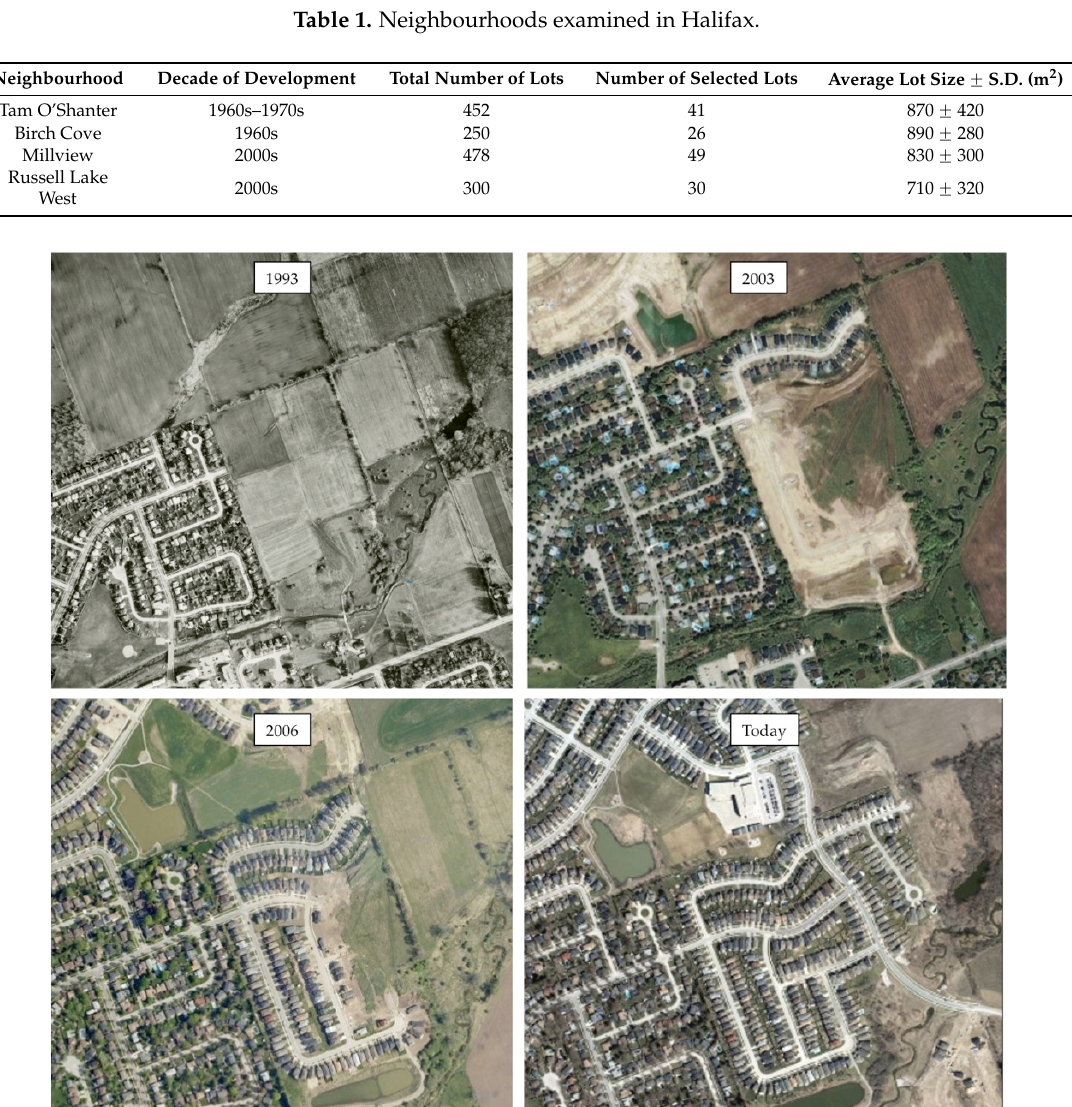
Figure 2. Aerial imagery showing the development of Millview (Halifax, Nova Scotia) from woodland to subdivision. Source: Google Earth © DigitalGlobe.